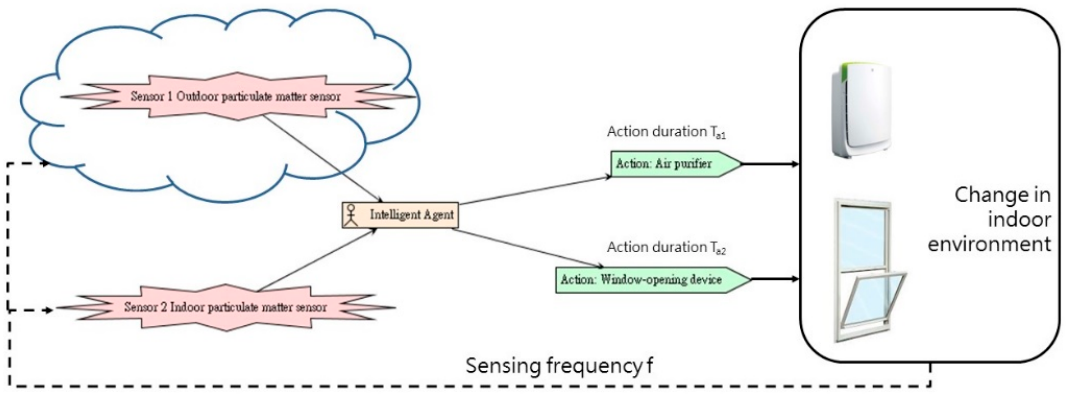
Figure 9. Schematic diagram of system connections.